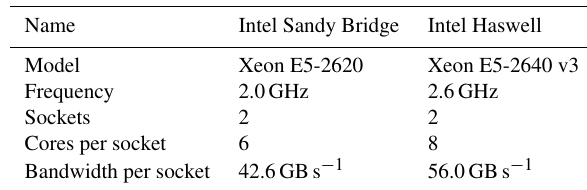
Table 2. Hardware